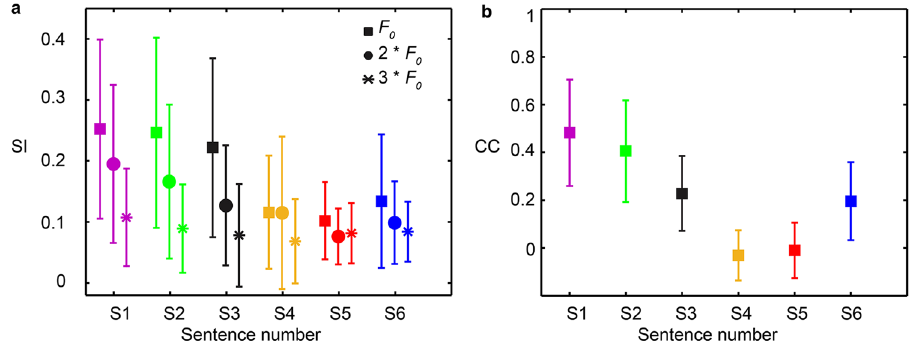
Figure 4. The average and standard deviation of the SI of 36 single units is shown for F 0 and the 1 st and 2 nd harmonic of the selected voiced syllable “o” from “the silly boy is hiding” ( a ). The average and standard deviation of the CC between the spectra of neural PSTH from 36 single units and the corresponding acoustic spectra ( b ). The BF of these neurons ranged from 600 Hz to 3600